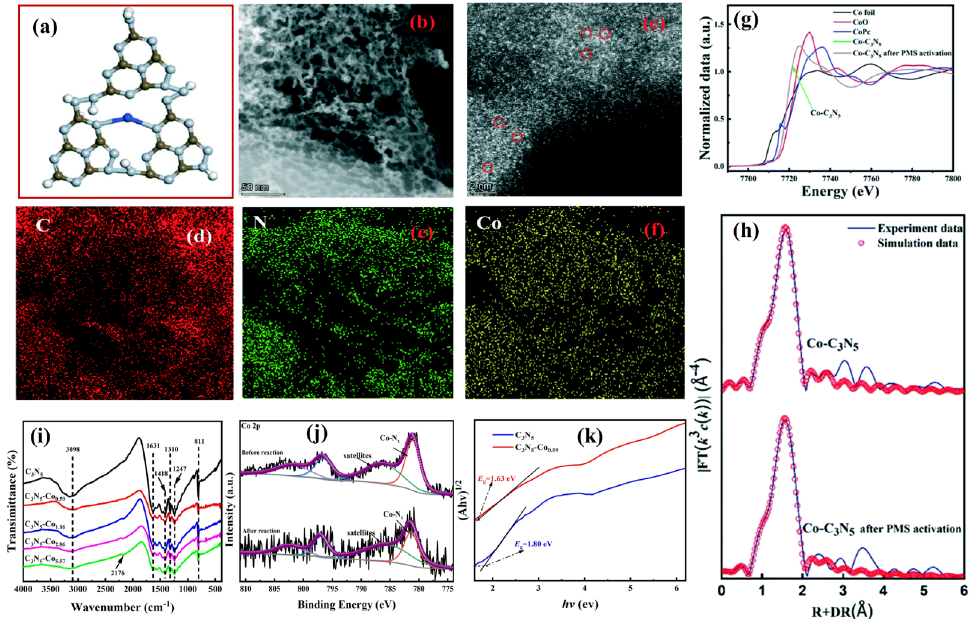
Figure 7. Co-C 3 N 5 ( a ) Doping structure; ( b ) HR-TEM image; ( c ) HAADF-STEM images; ( d – f ) elemental mapping; ( g ) XANES spectra; ( h ) R-space of XANES; ( i ) FT-IR spectra; ( j ) XPS spectra of Co 2p ; ( k ) Tauc’s plot. ( a – h ) Adapted with permission from [32]. Copyright Royal Society of Chemistry, 2022. ( i – k ) Adapted with permission from [33]. Copyright Elsevier B.V., 2022.